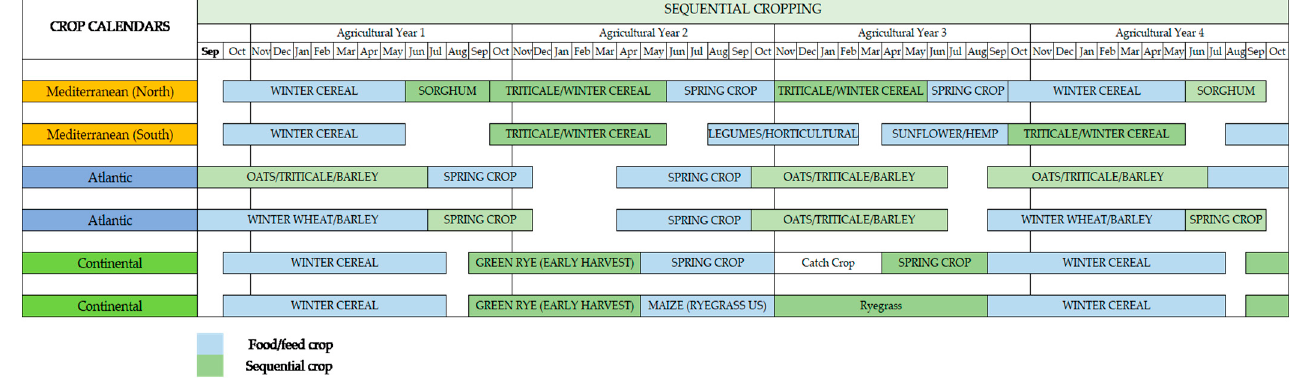
Figure 3. Sequential cropping calendars.